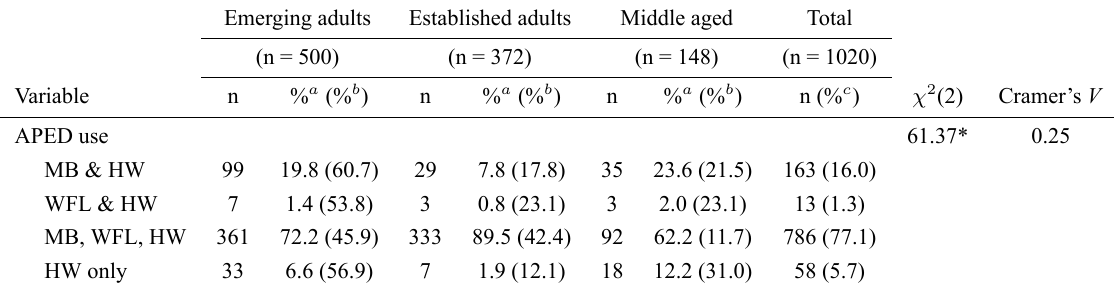
Table 3. Frequencies and chi-square results for age cohort and aped usage by